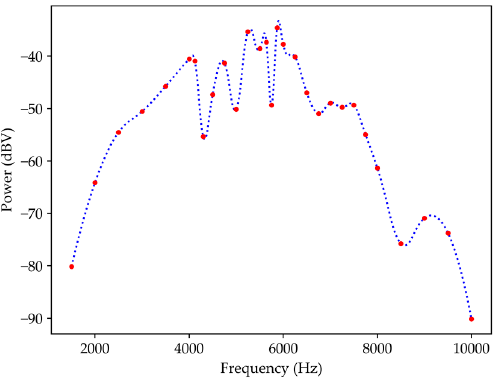
Figure 10. Transfer function in relation to an oscillating surface for a wavelength of 1570 nm and with the sensor parallel to the oscillating plate.